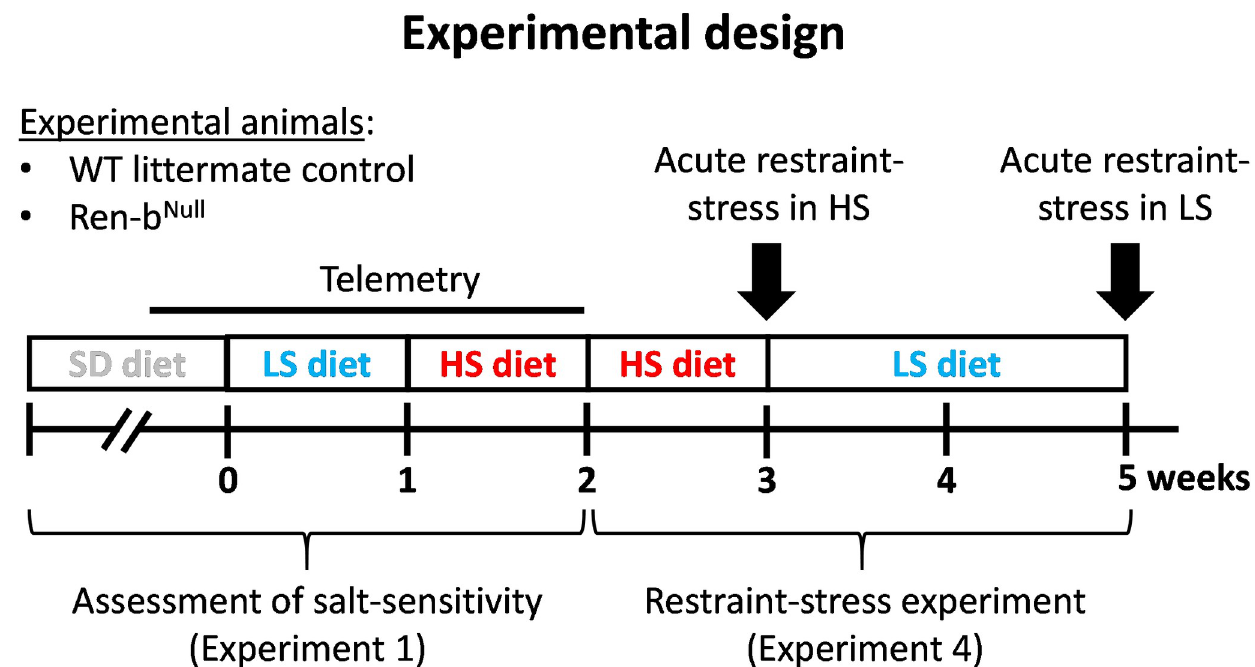
Fig 1. Experimental protocol. The assessment of salt sensitivity (Experiment 1) and susceptibility to restraint-stress (Experiment 4) were performed in the same animals. Male Ren-b Null or wildtype (WT) littermate controls were instrumented with a radiotelemetry catheter and housed in a quiet environment for blood pressure and heart rate measurements. In experiment 1, baseline arterial blood pressure and heart rate were recorded for 3 days under a standard salt diet (SD, 0.8% NaCl). Subsequently, the diet was switched to a chow containing low sodium (LS, 0.02% NaCl), and data were acquired for 7 additional days. Finally, the diet was switched from low to high salt containing diet (HSD, 4% NaCl), and data were acquired for 7 additional days. To study responses to acute restraint stress in both HSD and LSD, the animals were continued on HSD for an additional week. By the end of the second week on HSD, mice were placed to an acrylic restrainer to assess the acute cardiovascular responses to restraint-stress. Next, mice were fed LSD for two weeks and the acute responses to restraint-stress were reassessed again.